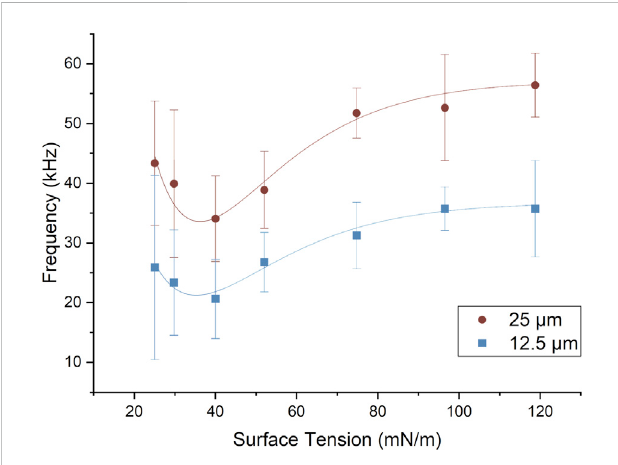
FIGURE 7 Droplet generation as a function of surface tension for both 12.5and25 µmneckwidthmodels.Asexpected,foraconstant fl owrate, the frequency shows an inverse trend to the droplet diameter shown in Figure 5. The error bars are the standard deviation.